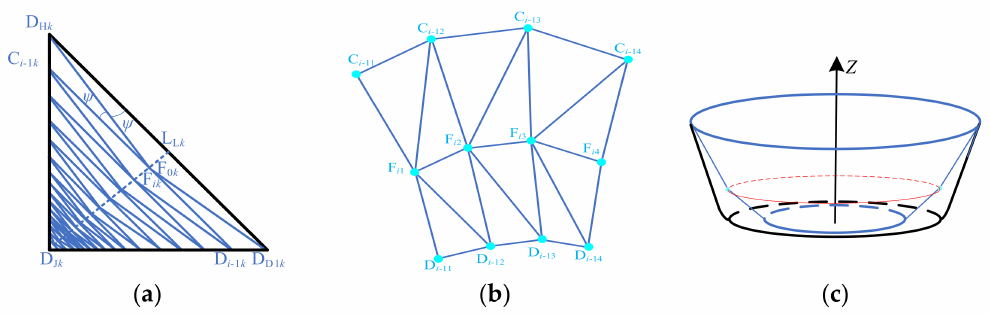
Figure 5. The sheet surface of the second stage forming: ( a ) longitudinal section; ( b ) triangular mesh; and ( c ) three-dimensional model of the sheet